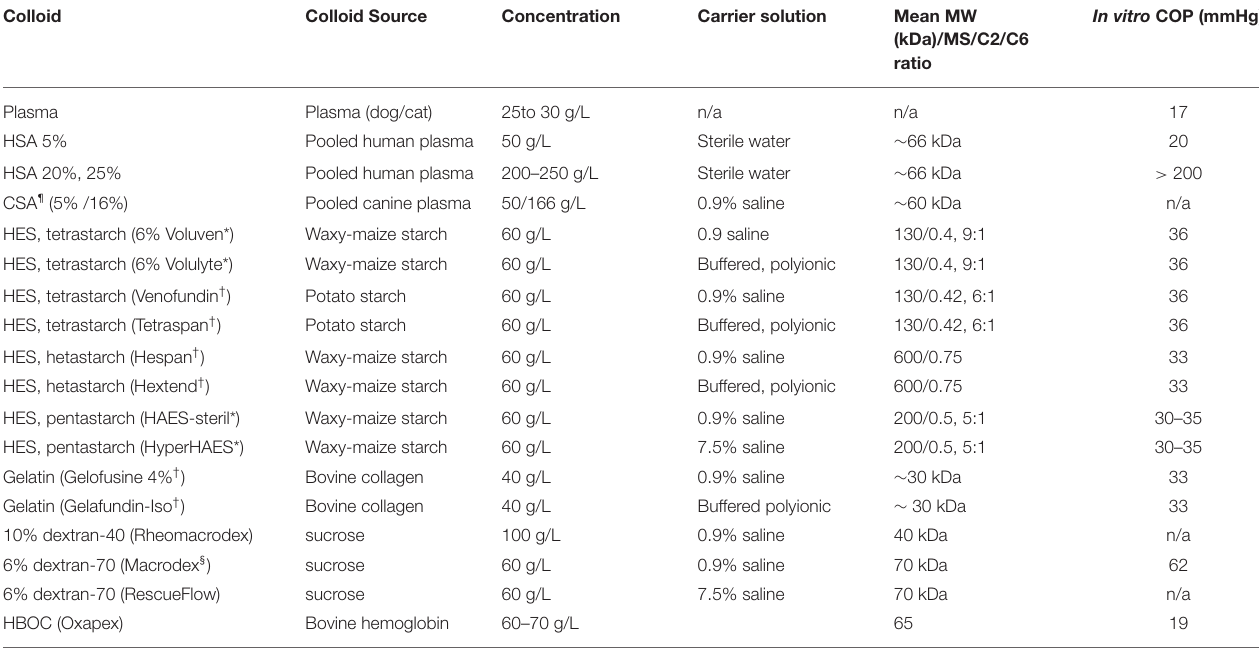
TABLE 1 | Synthetic and natural colloids and their physicochemical characteristics.